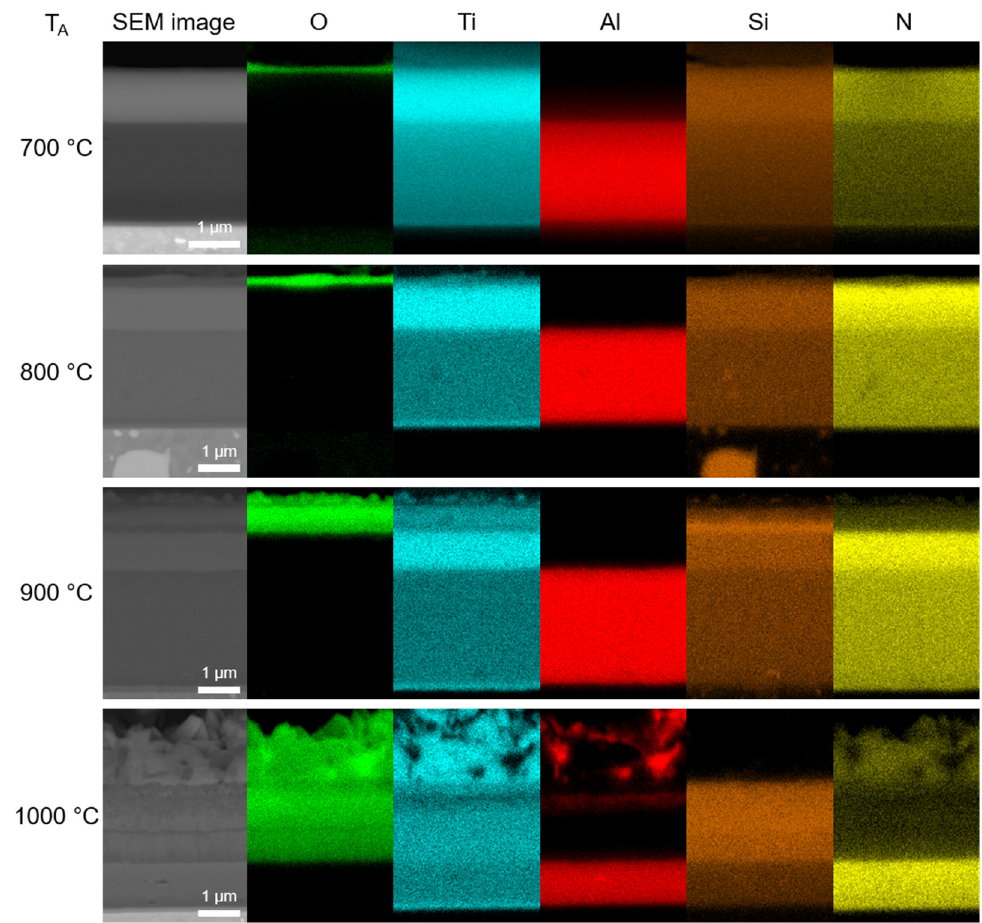
Figure 6. EDX elemental maps of the cross-section of annealed coatings (T A —annealing tempera- ture). Table 3. Chemical composition of AlTiSiN/TiSiN coatings measured by EDX in the cross-sections.